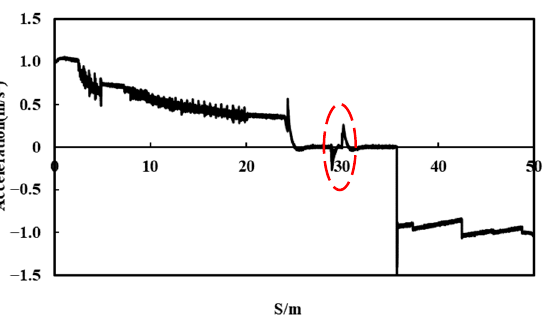
Figure 15. The whole acceleration of the train when the fault occurs during constant speed.